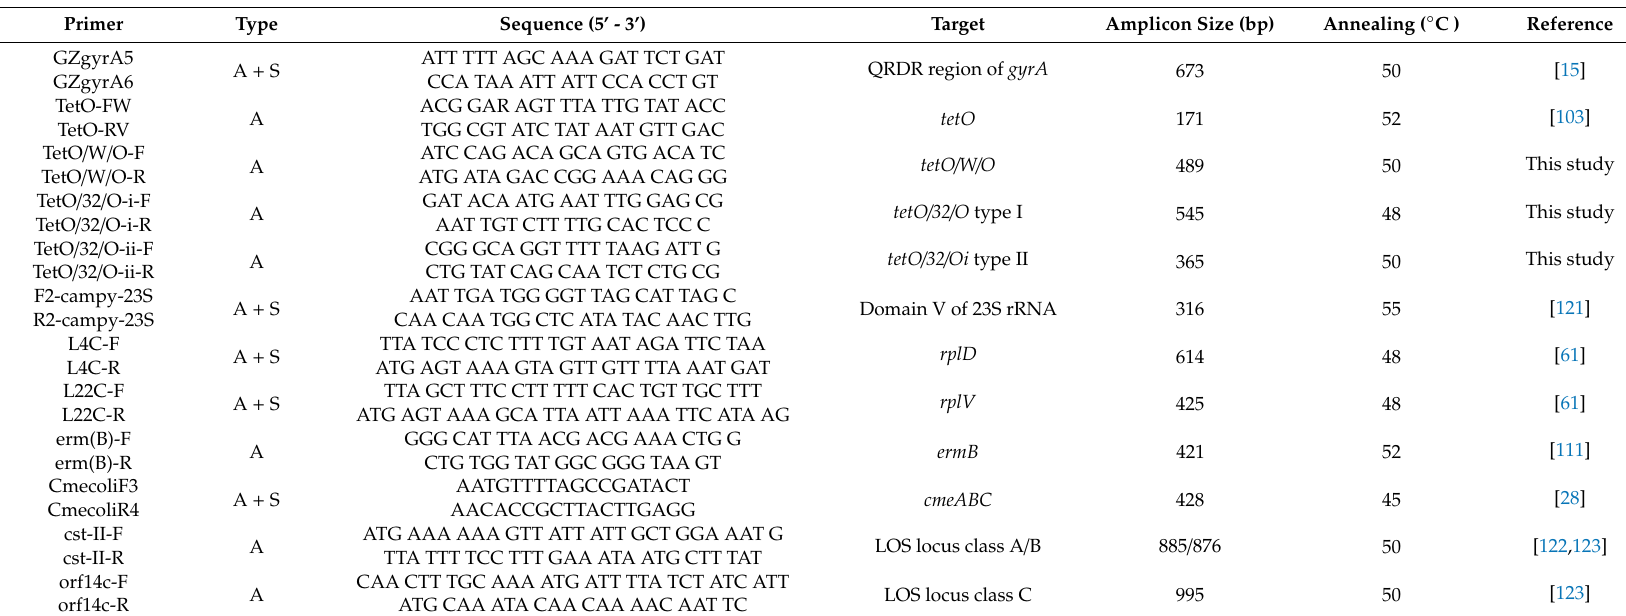
Table 4. Primer sequences and target genes used for the detection of antimicrobial resistance determinants in resistant thermophilic Campylobacter spp. isolates and sialylated lipooligosaccharide (LOS) locus classes A, B and C in streptomycin-resistant C. jejuni